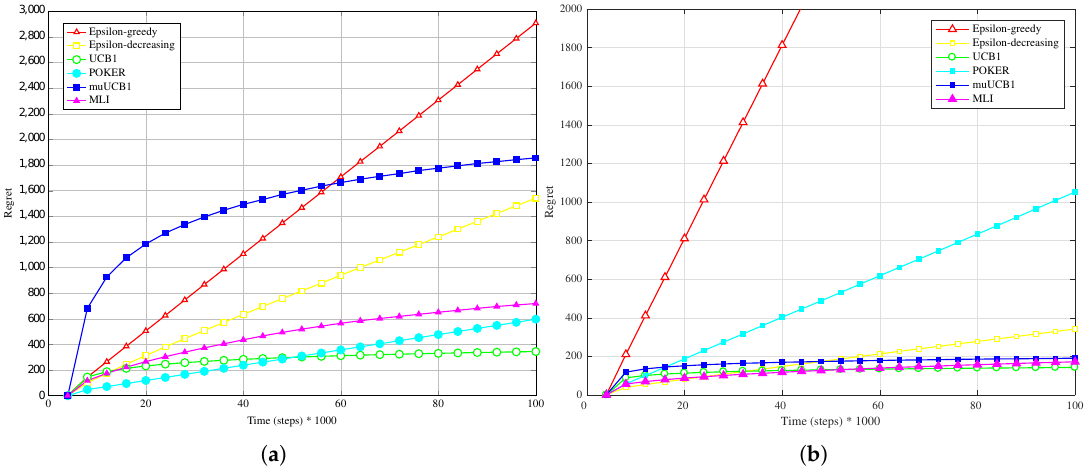
Figure 1. Performance in terms of regret of the six considered algorithms, with a Bernoulli distribution for the reward Probability Density Function (PDF) and T U / T M = 1. ( a ) Hard configuration; ( b ) Easy configuration.